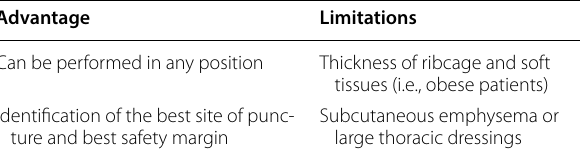
Table 3 Advantages